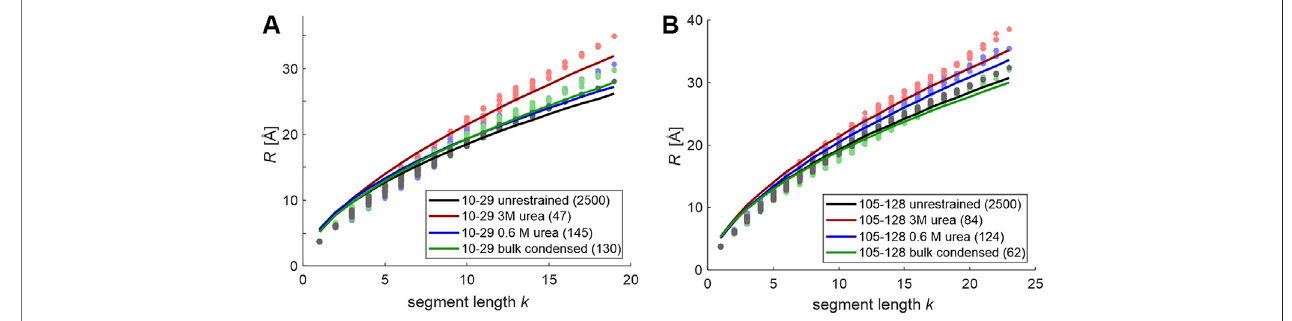
FIGURE 3 | Segment-wise root mean square CA-CA distances (dots) for chain sections 10 – 29 in FUS 1 – 100 (A) and 105 – 128 in FUS 67 – 166 (B) and attempted fi ts by ascaling law b · k ν . For unrestrained ensembles, the average is over 2,500 conformers with uniform population. Forrestrained ensembles, the average population- weighted and the number of conformers in the fi tted ensembles is given in the legend in